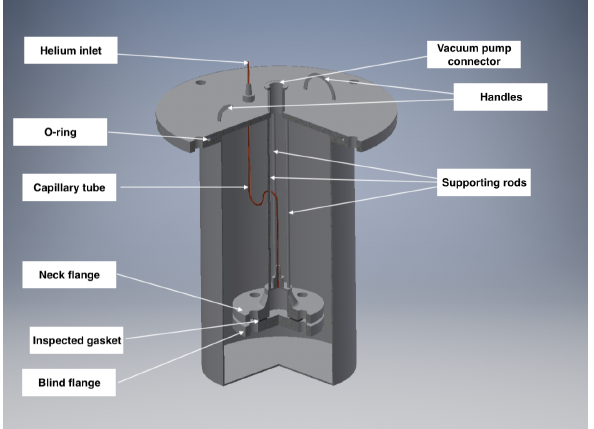
Figure 2: Construction of the test chamber and flanged